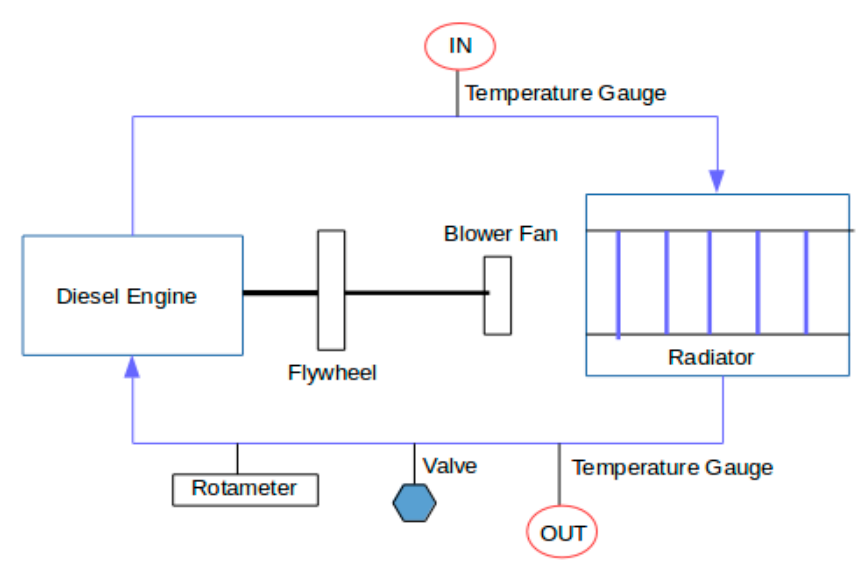
Figure 2. Schematic line diagram of the experimental setup.